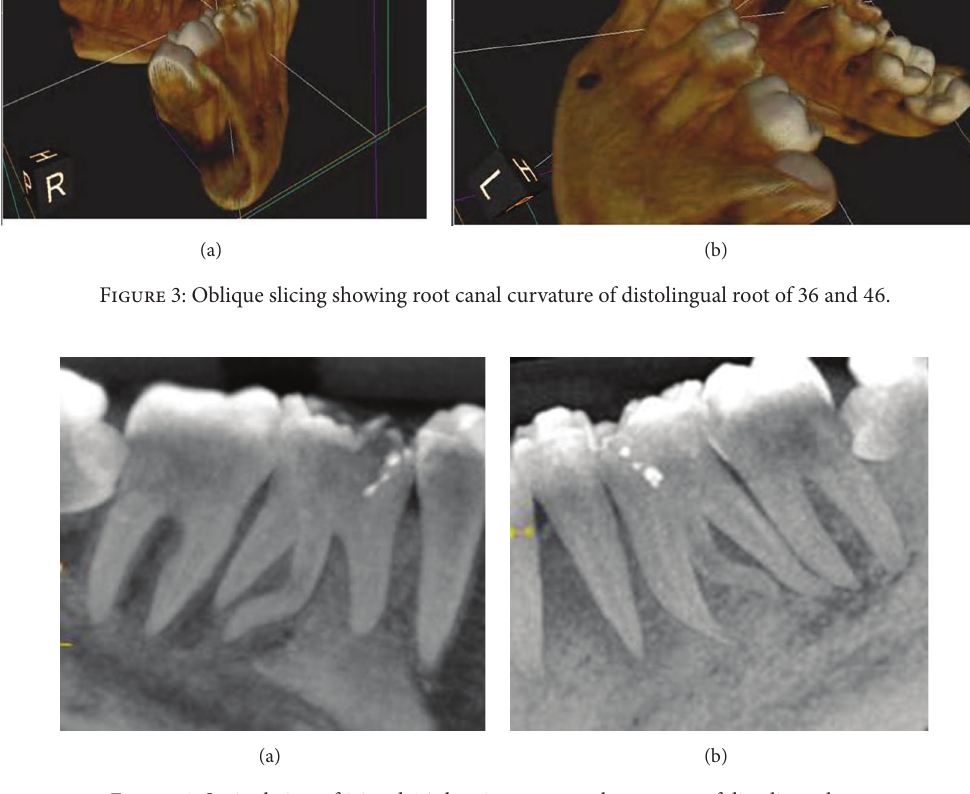
Figure 4: Sagittal view of 36 and 46 showing root canal curvature of distolingual root.